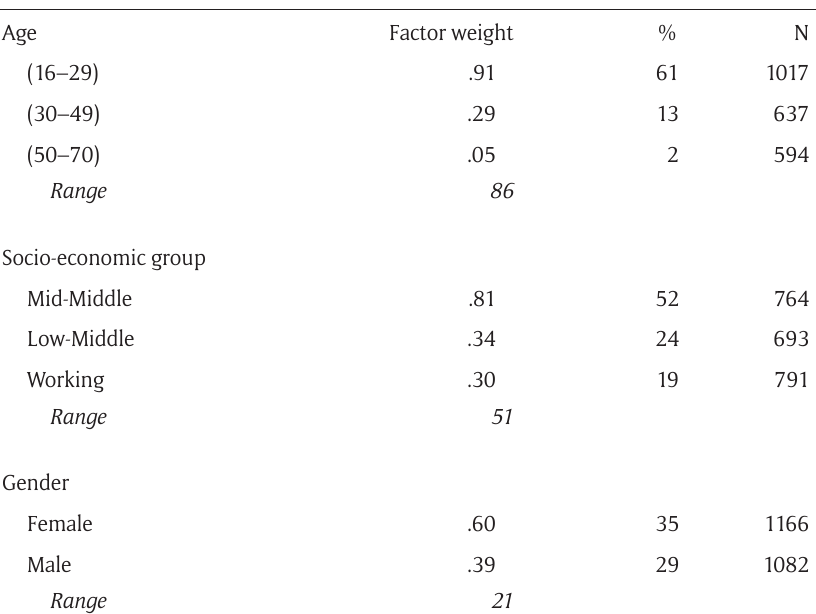
Table 14: Variable rule analyses of the contribution of social factors selected as significant to the probability of palatalization of /ti/, /di/ in UP (1995 data). Note : All extralinguistic factor groups selected as statistically significant (adapted from Carvalho,